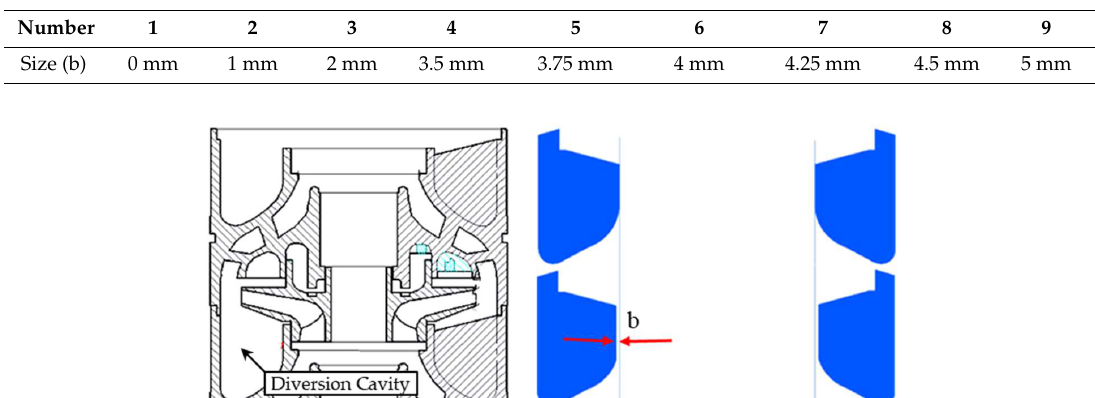
Table 1. Optimization dimension of the diversion cavity.